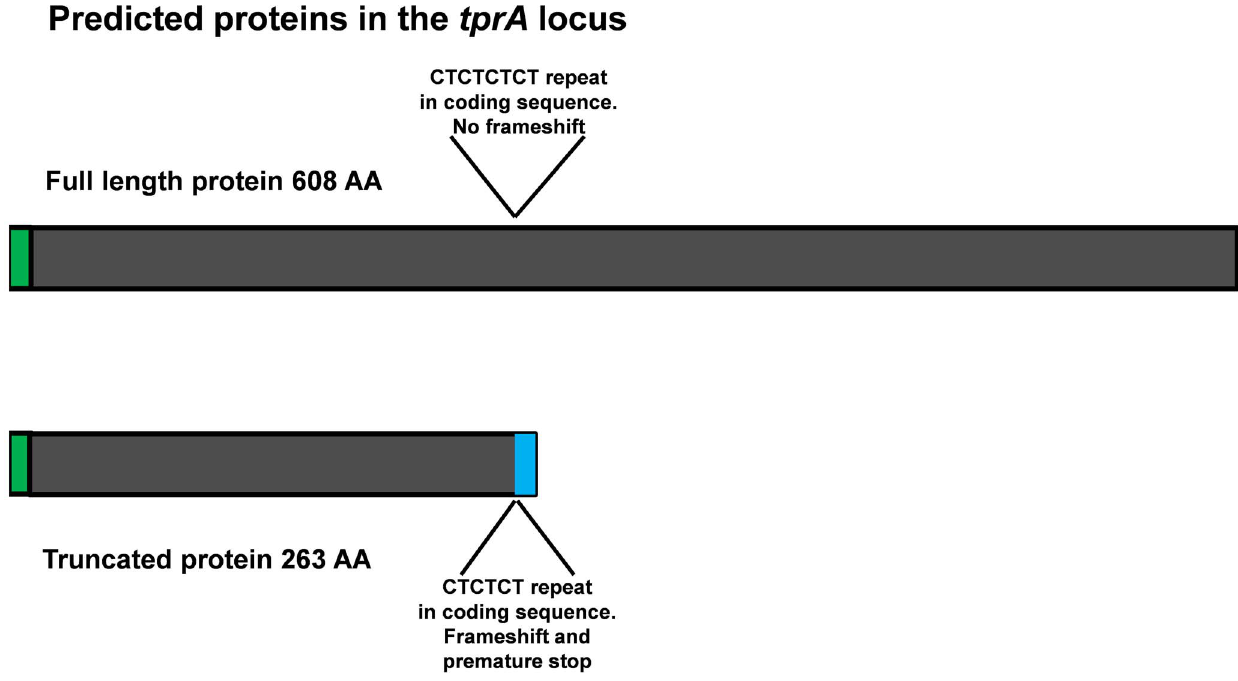
Figure 5. Encoded variants at the tprA locus. The Nichols, Bal3, Mexico A, and Street 14 isolates carry a gene encoding a truncated protein as result of the presence of only 3 CT dinucleotide repeats. A gene coding for a full length protein, which contain 4 CT dinucleotide repeats, is found in Sea81-4, Gauthier, Samoa D, CDC2, Iraq B, Bosnia A, Fribourg-Blanc and Cuniculi A. Blue color, unique sequence as result of frameshifting. Green, signal peptide.